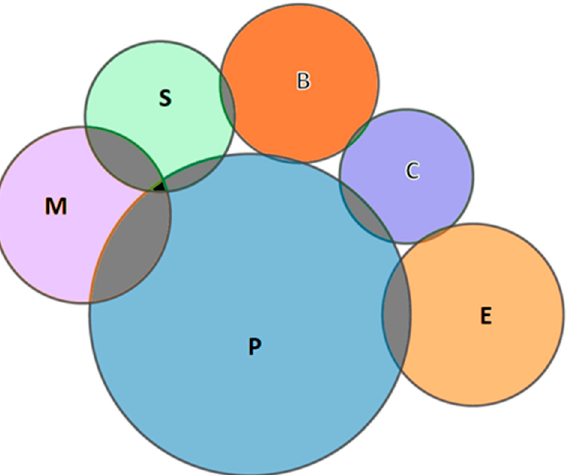
Figure 5. Venn diagram of the interrelations between areas of knowledge. P: Psychology; E: Education & Educational Research; M: Biomedical Social Sciences; B: Business & Economics; S: Social Sciences—Other Topics; C: Communication.